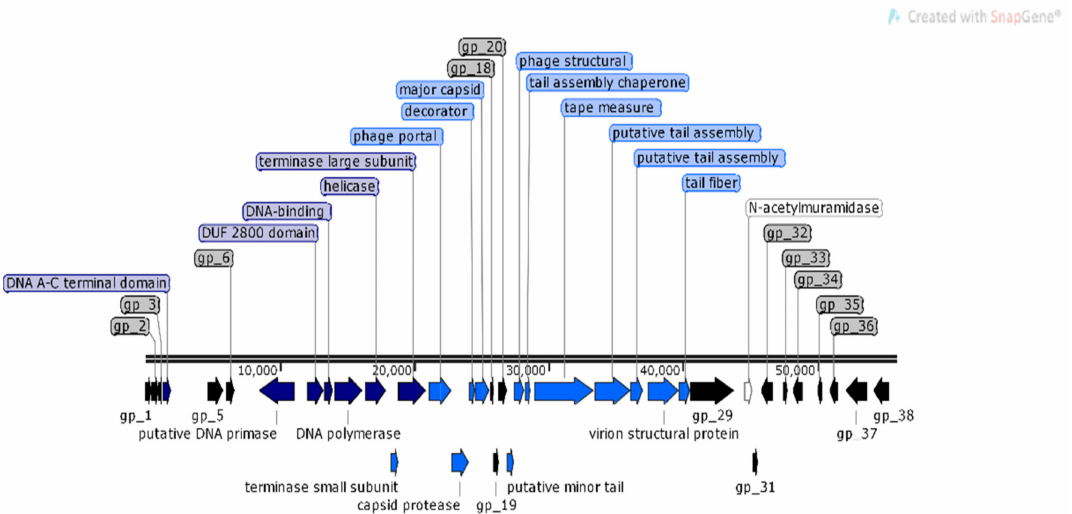
Figure 3. Structural and functional annotation map of ϕ MA11 bacteriophage (55,830 bp) for 55 open reading frames (ORFs) encoding proteins. ORFs coding for the following proteins: hypothetical (black), structural proteins (light blue), proteins for phage replication and lifecycle (dark blue), lysis (white). For ϕ MA12 genome nine ORFans were identified with ( E –values > 0.001), 22 ORFs with predicted functions and 29 hypothetical proteins (Figure